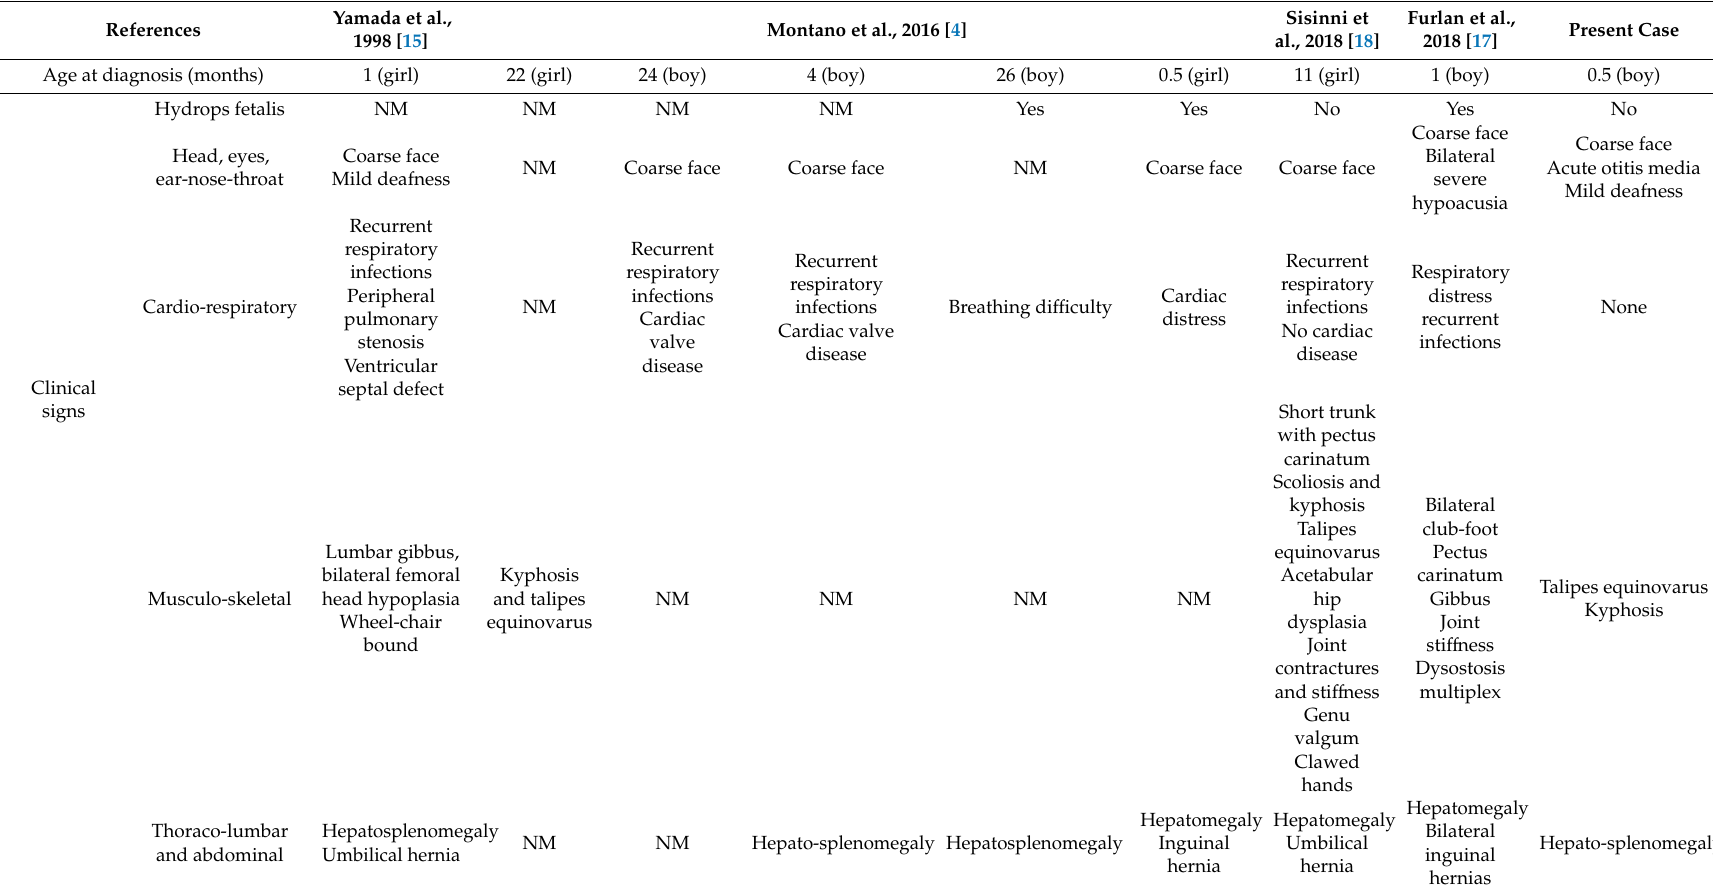
Table 1. Evolution of clinical features in patients who underwent bone marrow transplantation or HSCT. This table does not include the female patient described by Islam et al. [16], who was transplanted at the age of 11 months and survived at least 2 years, and for whom very scarce information is